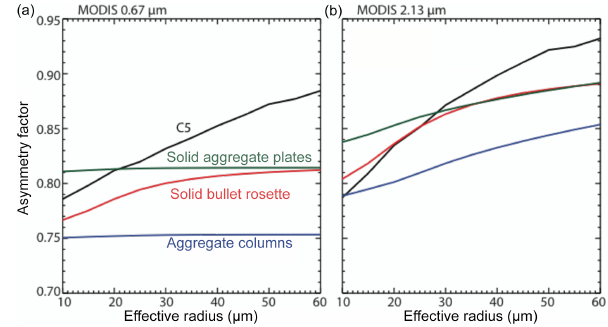
Figure 5. The relationship between effective radius and single- scattering co-albedo in the MODIS (a) 2.13 and (b) 3.7µm channels for different ice particle radiative models. See Fig. 6 for model de- tails. Since effective radius retrievals for an optically thick cloud are a retrieval of co-albedo, the difference between the C5 and aggre- gated column model co-albedo implies a retrieved effective radius difference of + 2 and − 8µm, respectively, for a C5 effective radius retrieval of about 35µm.